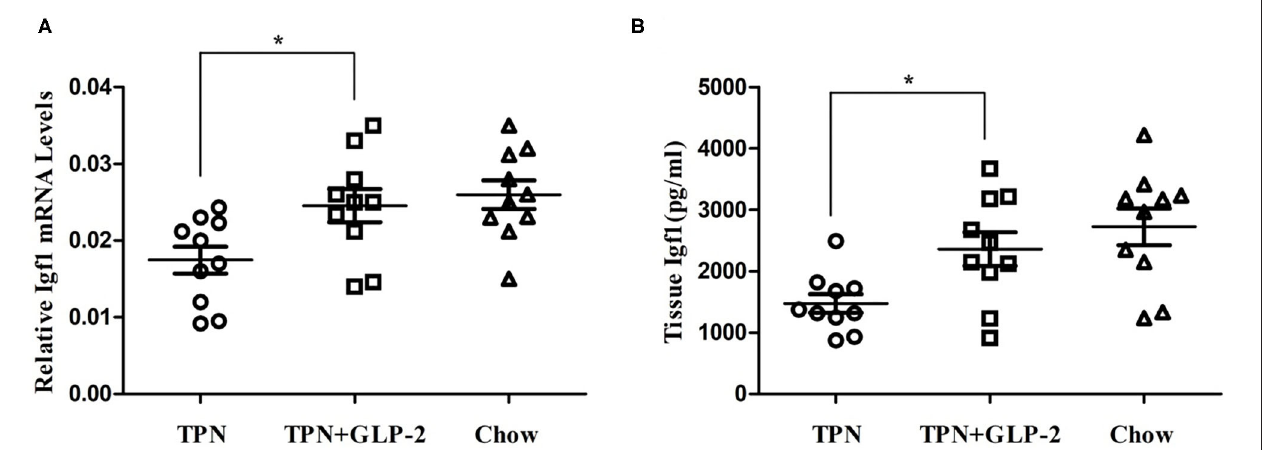
FIGURE 4 | The intestinal tissue the expression of insulin like growth factor-1. (A) Expression of insulin like growth factor-1 mRNA. (B) Expression of insulin like growth factor-1 protein. Where *indicates p < 0.05 for TNP vs. TPN + GLP-2 and Chow.